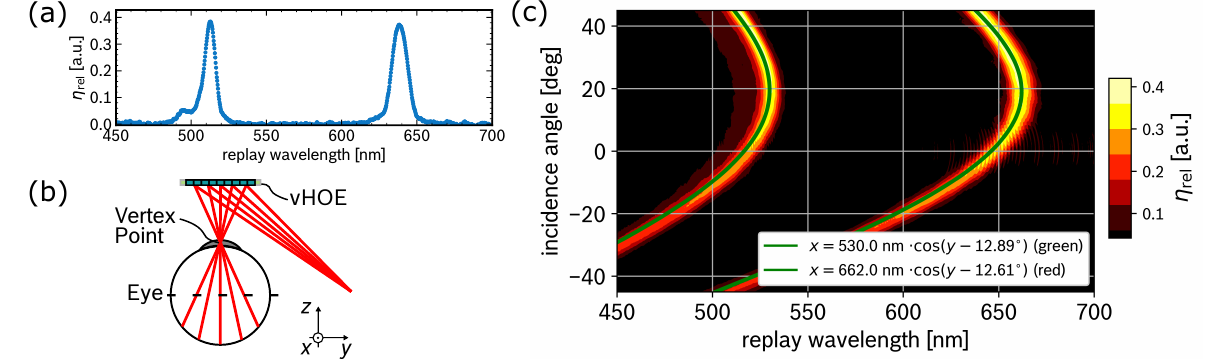
Figure 9. ( a ) Chromatic relative diffraction efficiency of the vHOE measured at a fixed incidence angle of ϑ = 45°. ( b ) Schematic of the vHOE’s global optical function with a single vertex point. ( c ) Two-dimensional contour graph, which outlines the vHOE’s relative diffraction efficiency η rel ( ϑ , λ ) as a function of the horizontal incidence angle ϑ and the probing wavelength λ . Two fit functions are applied to the outlined dataset using Bragg’s equation (Equation